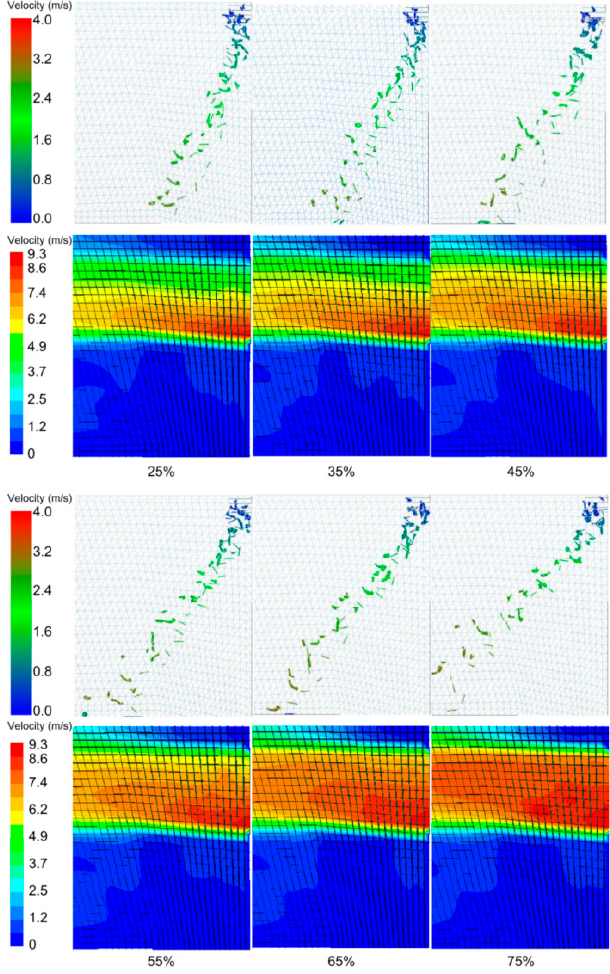
Figure 12. Tea material distributions and corresponding flow-field distributions.